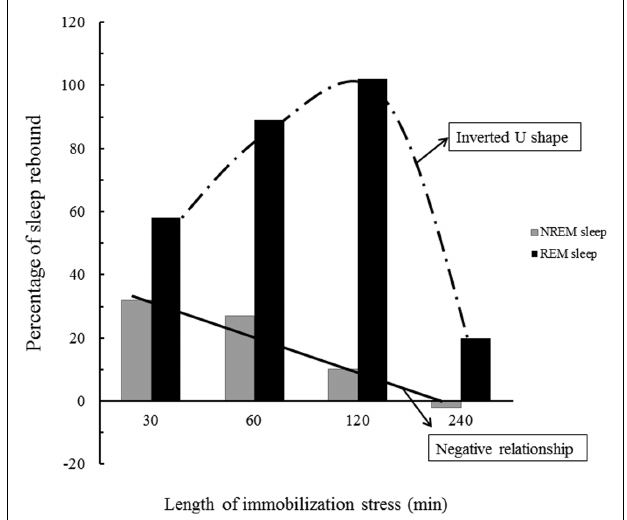
FIGURE 2 | Schematic representation the effects of stress on NREMS and REMS rebound. The longer the stress period the higher the corticosterone (CORT) secretion and as a consequence, there is a gradual inhibition of NREMS rebound. REMS, however, is regulated by optimum levels of CORT, so either very low or very high levels (induced by very short or very long periods of stress) result in meager rebound. Data is adapted from Marinesco et al.